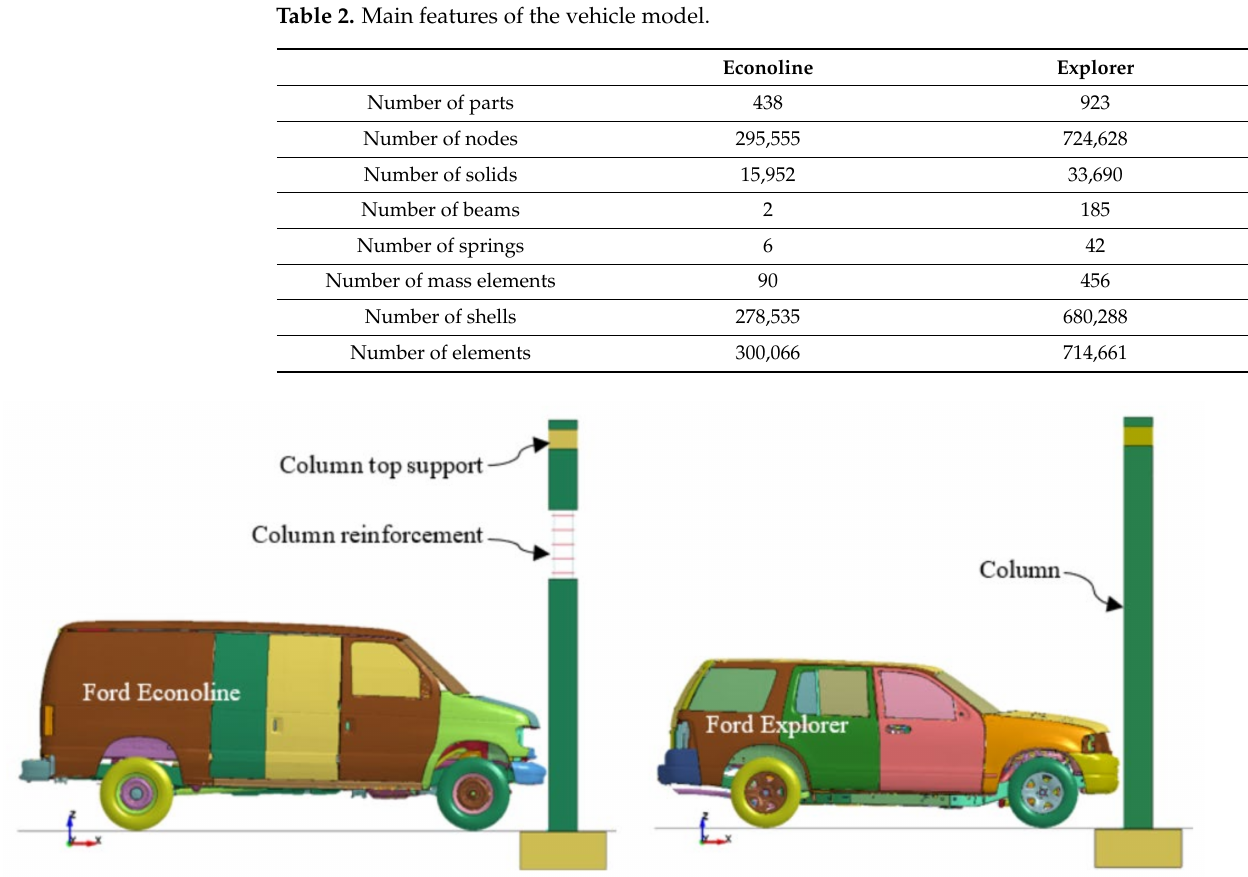
Figure 6. Finite element model of the Ford Econoline and Explorer vehicles with a column at a parking